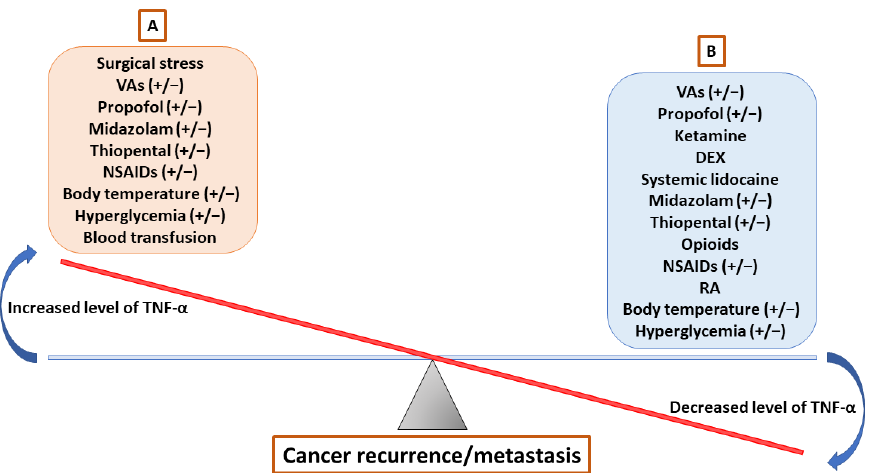
Figure 2. A theory of balance between TNF-α-promoting and -inhibiting factors contributing to can- cer recurrence/metastasis. ( A ) Surgical stress and blood transfusion may promote cancer recur- rence/metastasis by increasing the TNF-α level; ( B ) ketamine, DEX, lidocaine, opioids, and RA may reduce cancer recurrence/metastasis by decreasing the TNF-α release. DEX = dexmedetomidine; NSAID = non-steroidal anti-inflammatory drug; TNF-α = tumor necrosis factor alpha; VA = volatile anesthetic; RA = regional